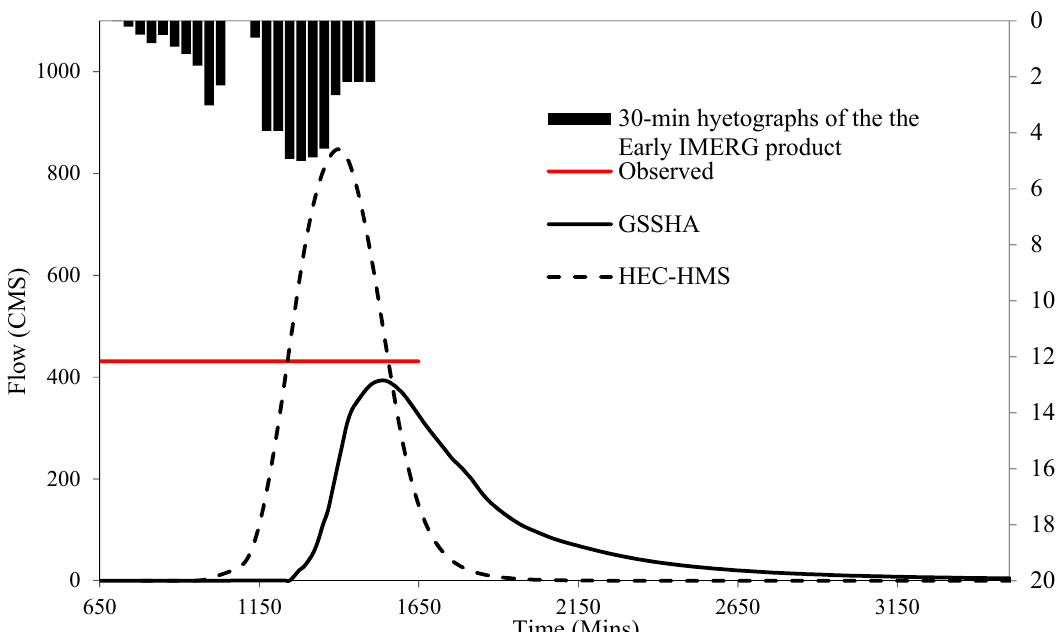
Figure 11. Comparison between simulated discharges for HEC-HMS and GSSHA models and the observed peak discharge at the outlet of Wadi Al-Nu’man before calibration.